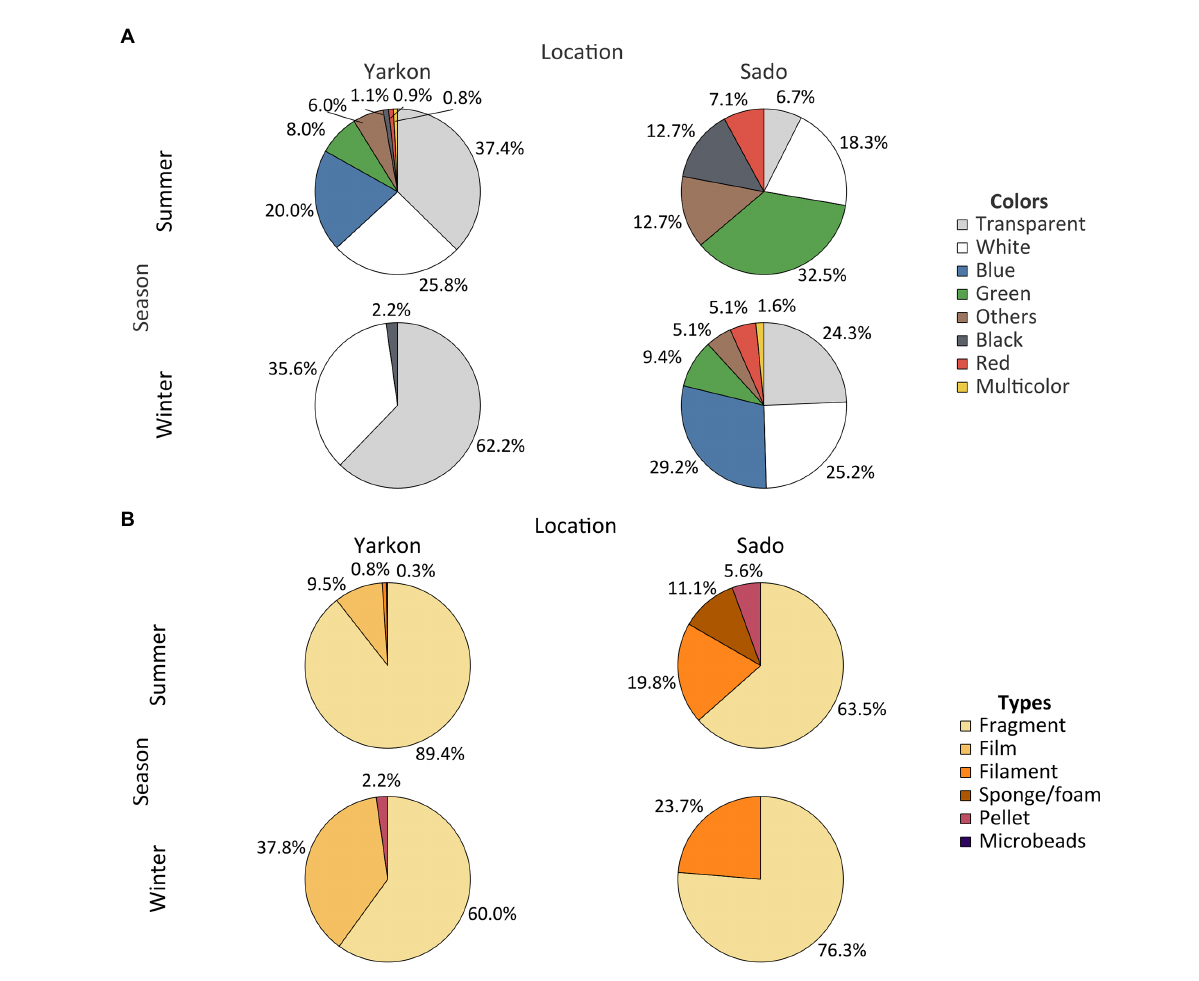
Figure 3A. PE was the most dominant polymer followed by PP or PS, depending on the location and season (Figure 3B). The Yarkon winter samples contained 21.4% of PS, which was absent from the summer samples, as well as higher percentages of thermoplastic elastomer (TPE; 7.1% vs. <0.5%) compared to the summer samples from the same location. The Sado winter samples contained higher percentages of PE (50% vs. 33.3% in the summer), PET (7.1% vs. 0% in the summer), and ethylene propylene rubber (EPR/EPM; 7.1% vs. 0% in the summer), whereas the summer samples consist of higher concentrations of PP (22.2% vs. 7.1% in the winter) and polyester (PES; 11.1% vs. 0% in the winter).